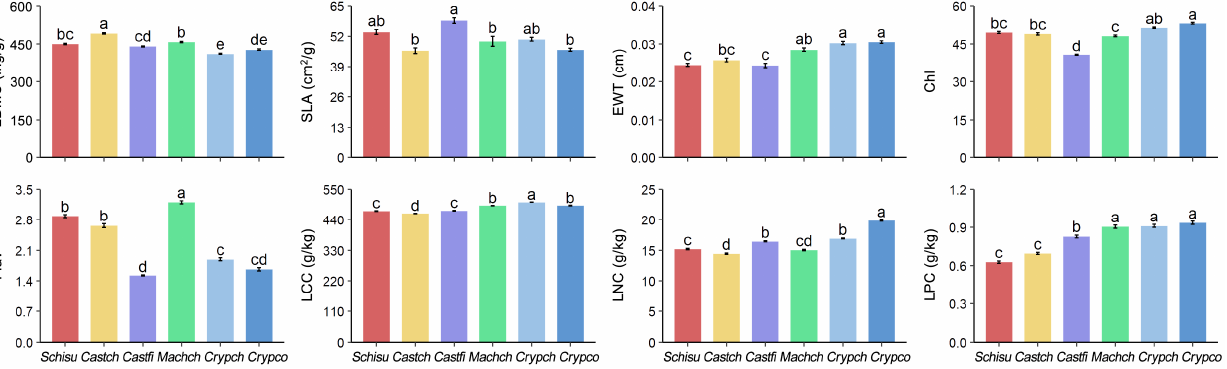
Figure 2. Interspecific variation in eight leaf functional traits (LDMC, SLA, EWT, Chl, Flav, LCC, LNC and LPC). Different letters (a, b, c, etc.) indicate a significant difference ( p < 0.05) between tree species in leaf trait values.